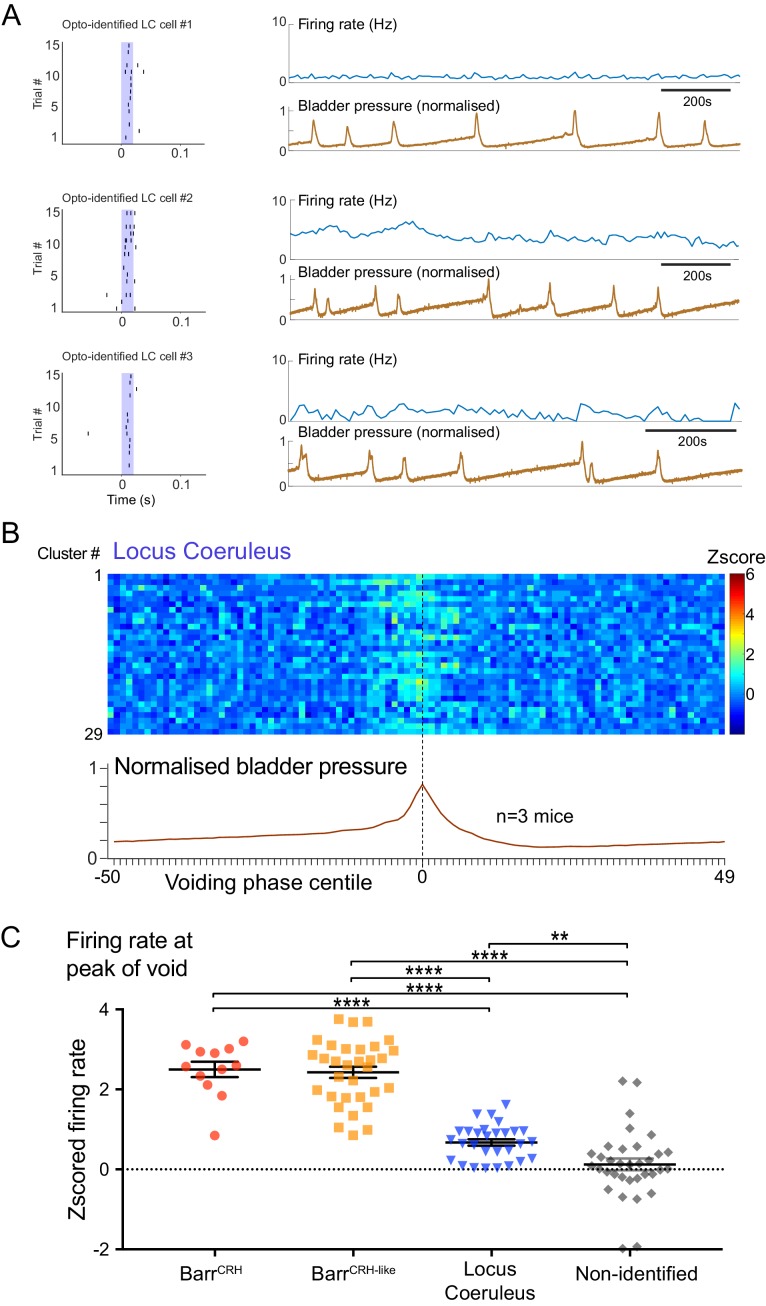
Dynamics of Locus coeruleus neurons with respect to the micturition cycle.(A) Recordings of opto-identified LC neurons showing entrained firing responses to blue light illumination (20 ms) and firing rate increases during the voiding contractions. (B) Firing rate heat maps (zscored) from recordings across mice (n = 3) with opto-identified LC neurons (n = 29) showed an increase in firing during the voiding phase (normalized bladder pressure across 3–6 voiding cycles). (C) Comparison of the increase in firing (zscored and averaged across five central centile bins centred on bladder pressure peak) showing that the BarrCRH and BarrCRH-like neurons have a greater increase in firing than LC neurons which in turn show a greater increase than the non-identified group (ANOVA with Holm-Sidak’s post hoc test, ****p<0.0001, **p<0.01). Source data in Figure 10—figure supplement 1—source data 1.Figure 10—figure supplement 1—source data 1.Data for 'Dynamics ofLocus coeruleusneurons with respect to the micturition cycle'.